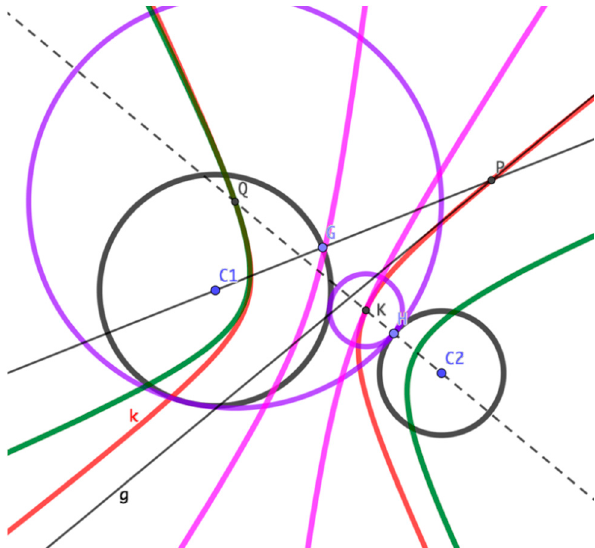
Figure 12. Drawing tangent circles to two given circles. The way to construct tangent circles to three given circles involves applying the previous method for two circles to circles with centers at C3 and C2 and circles with centers at C3 and C1, respectively (Figure 13). There are eight tangent circles to the given circles. The participants acknowledged that the number of solutions depends upon the relative position of the given circles. Here, they explored other cases that included two of the three circles intersecting, and two of the circles tangent to each other.